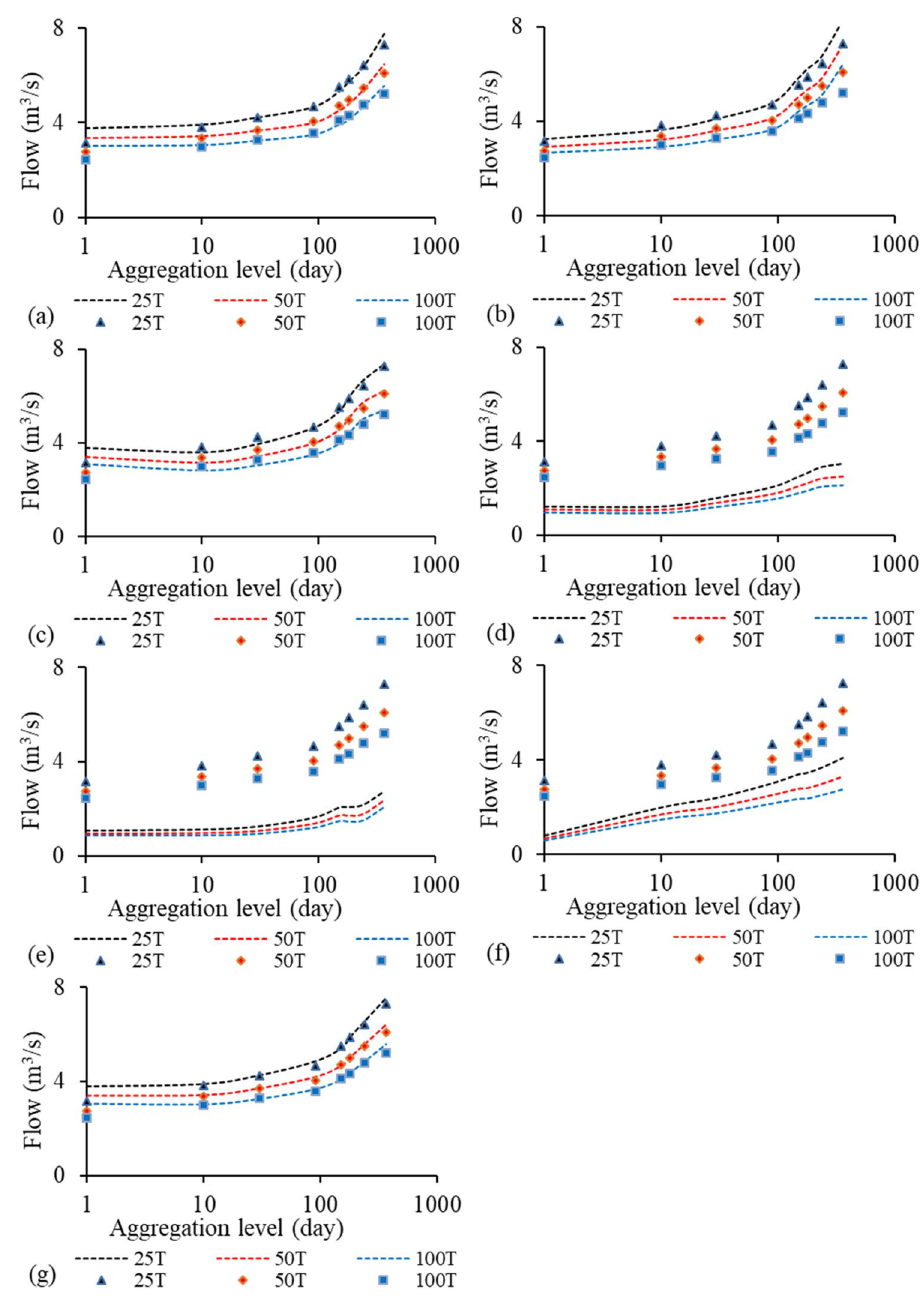
Fig. 13 The FDF plots for low extreme observed and simulated flows obtained at different aggregation levels (1–365 days) for a AWBM, b SAC, c TANK, d IHACRES, e SIM- HYD, f SMAR, g HMSV obtained at 25-, 50- and 100-year return periods. In the legend, dashed lines denote simulated flow,